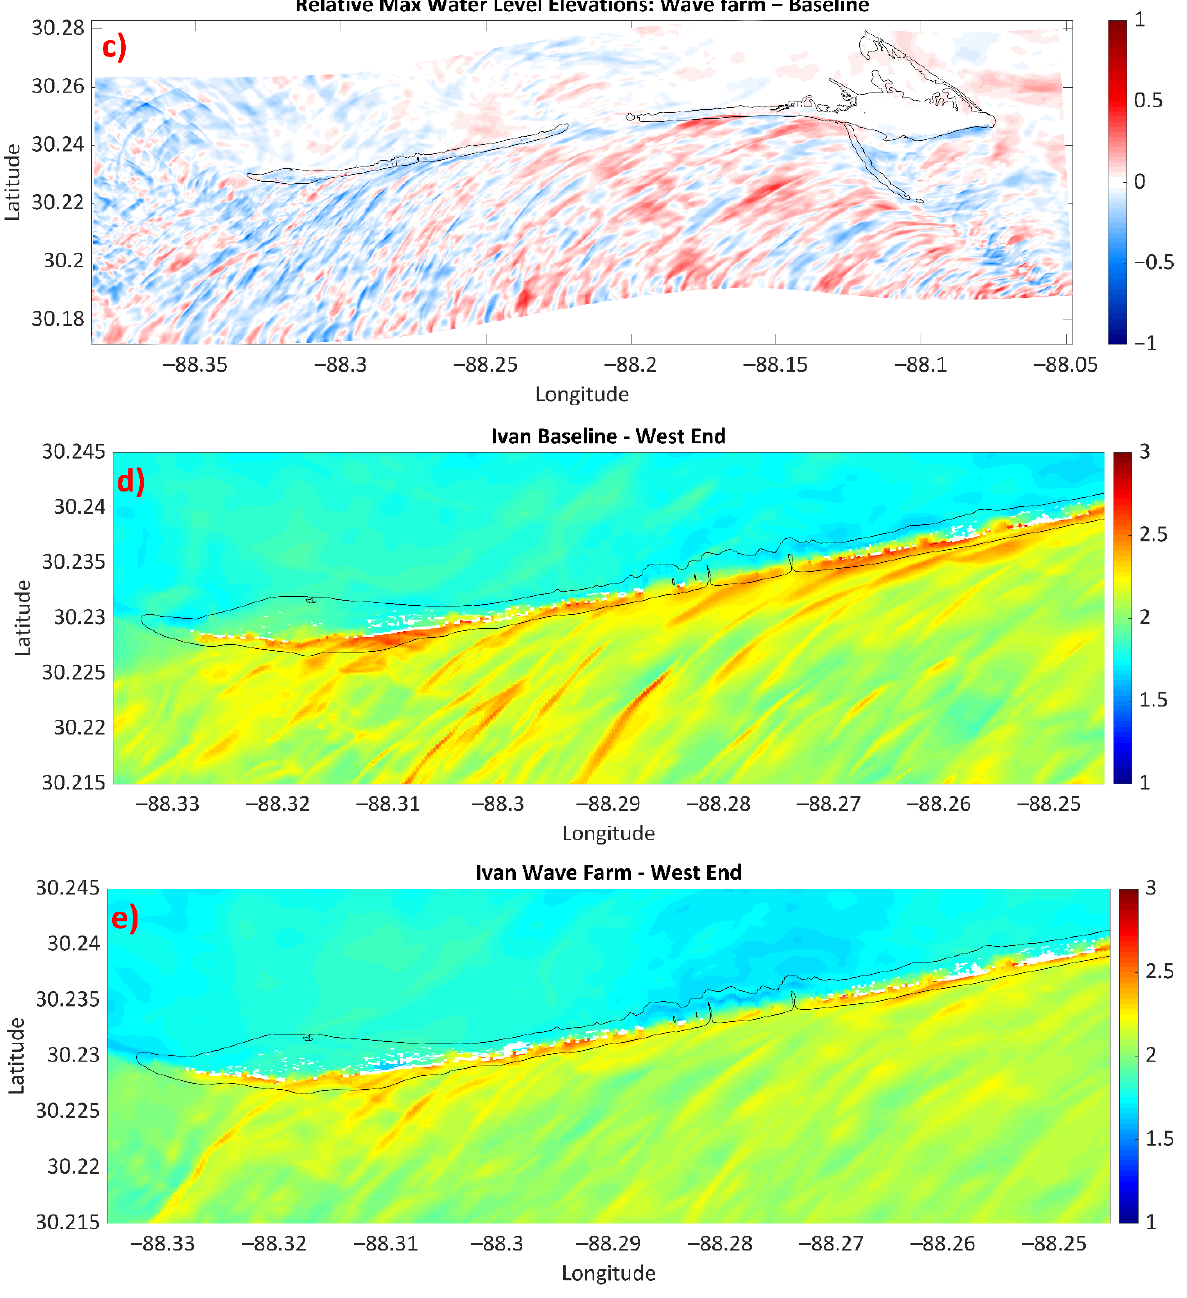
Figure 6. Maximum water levels [m] for baseline ( a ) and wave farm ( b ) scenarios for Dauphin Island, AL. ( c ) Difference between the two scenarios: ( b ) subtracted from ( a ). ( d , e ) Magnified versions of ( a ) and ( b ), respectively. White patches are the dry areas, and the black line is the poststorm zero-meter contour of the island.